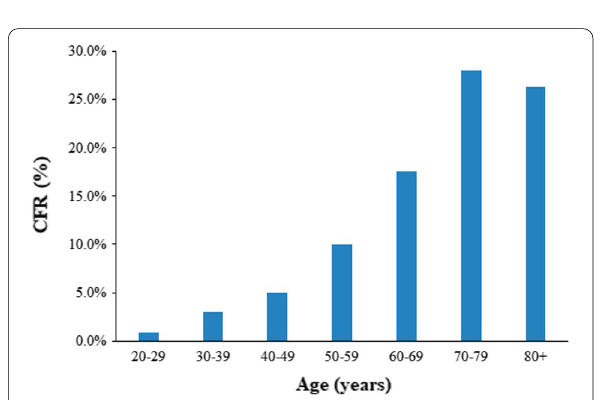
Fig. 6 Age-specific CFR (As per WHO consensus)